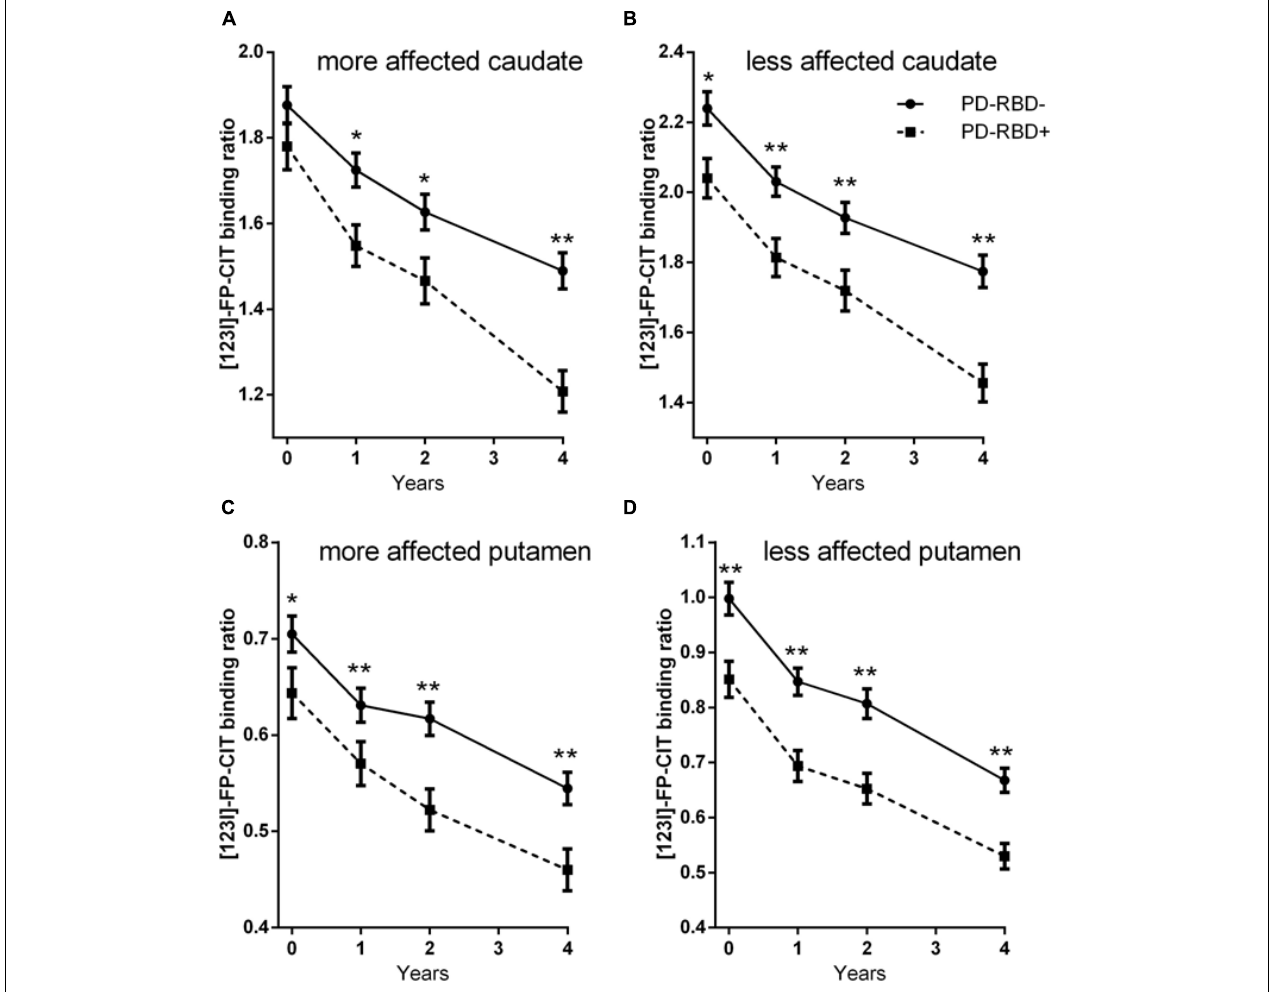
FIGURE 1 | 123 I-FP-CIT uptake ratios in the more affected side of the caudate (A) , the less affected side of the caudate (B) , the more affected side of the putamen (C) , and the less affected side of the putamen (D) at baseline and at follow-ups. Error bars indicate standard error of the mean (SEM). * p < 0.05; ** p <